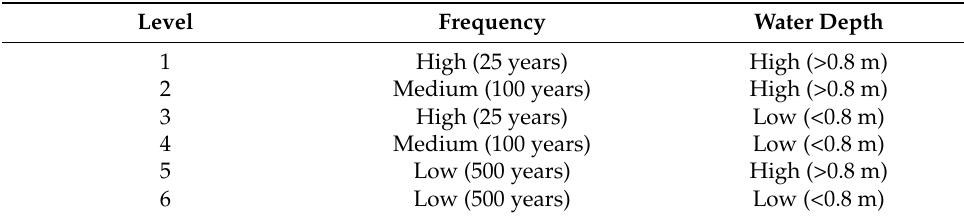
Table 1. Risk levels established by PATRICOVA.